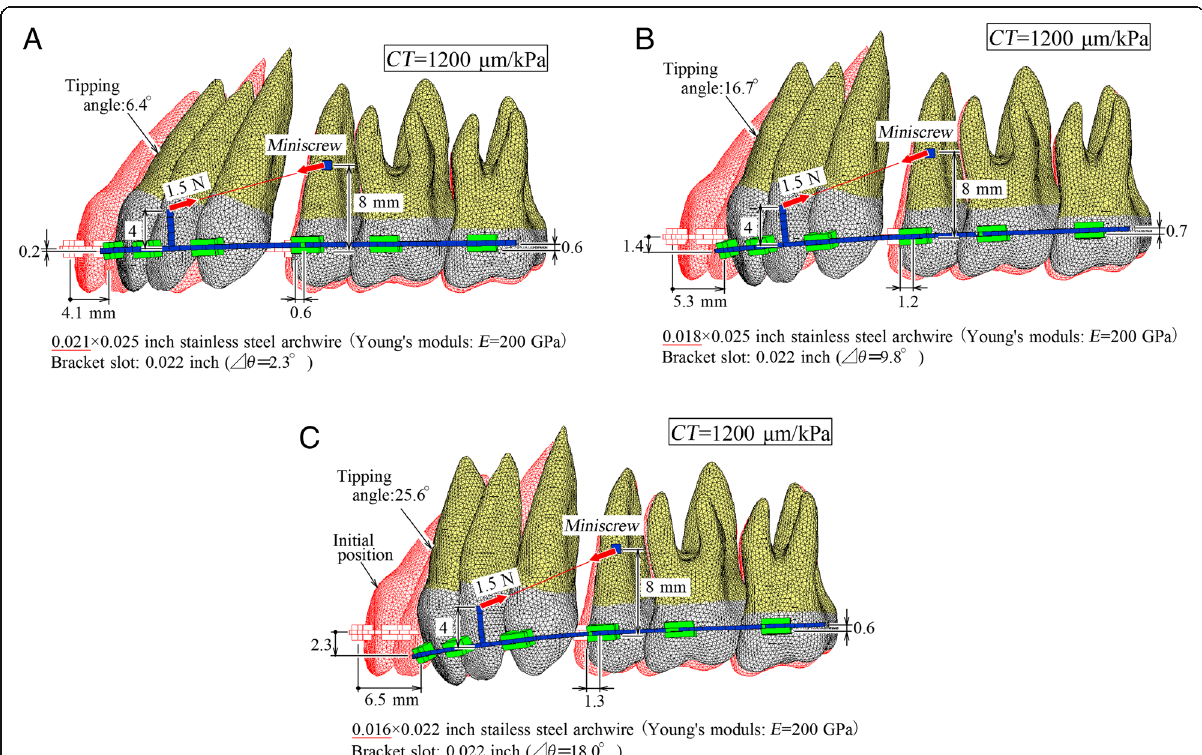
Fig. 2 Movement patterns when archwires of 0.021, 0.018, and 0.016 in. are inserted into brackets of 0.022 in.. Lingual tipping and extrusion of the incisor increased when decreasing the archwire size. Movements of the posterior teeth were about the same irrespective of the archwire size. a 0.021in. b 0.018in. c